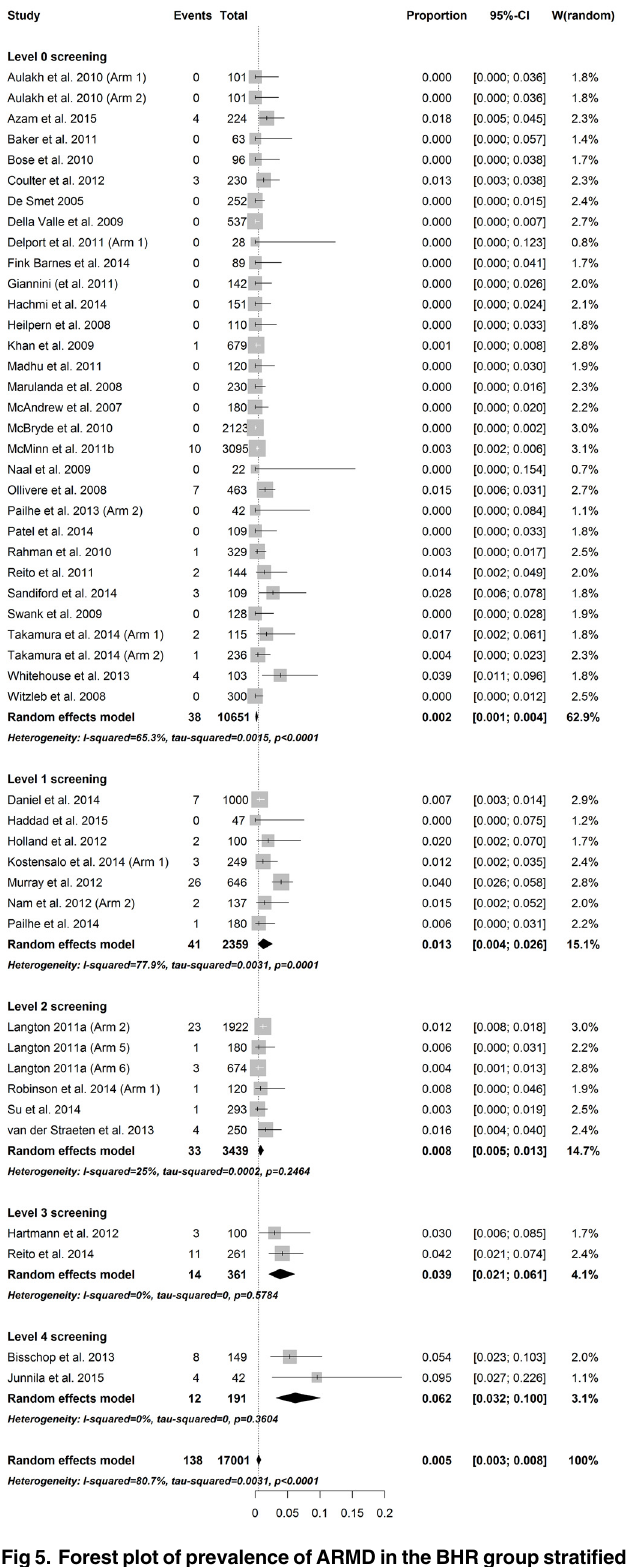
Fig 5. Forest plot of prevalence of ARMD in the BHR group stratified by level of screening.